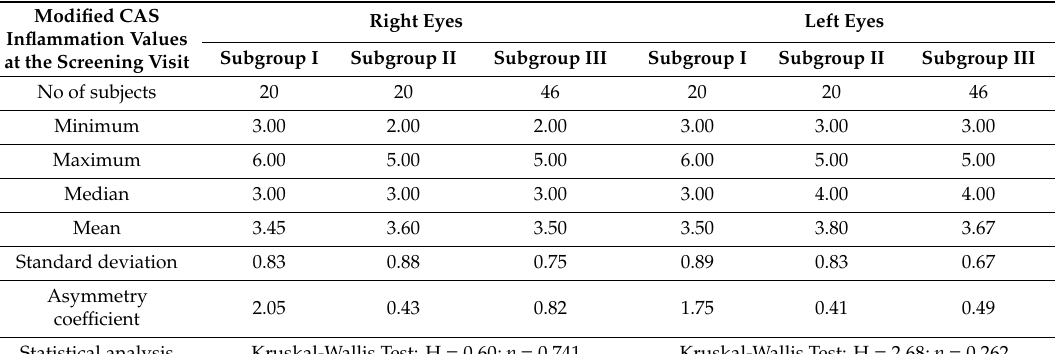
Table 6. Modified CAS inflammation form analysis in the study participant’s right and left eyes at the screening